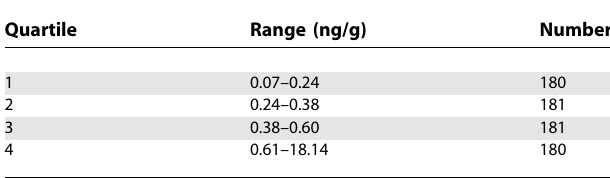
Table. Polychlorinated Biphenyls in Cord